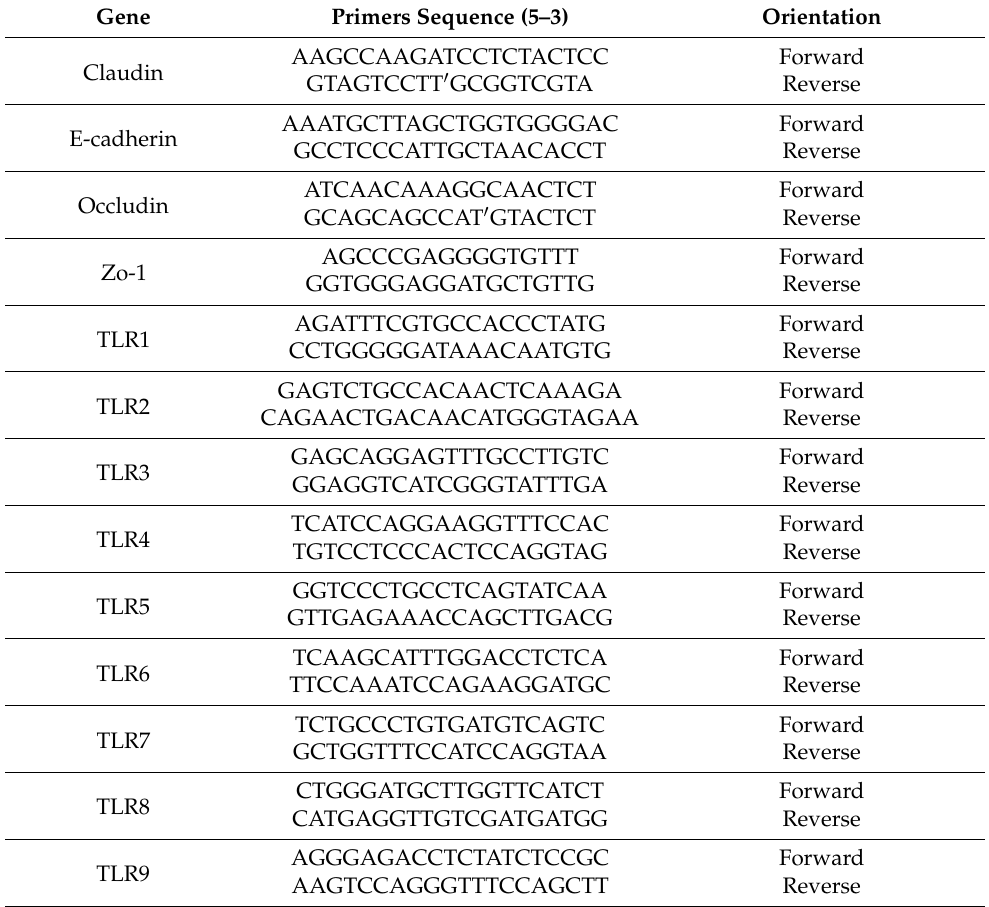
Table 2. Oligonucleotide PCR